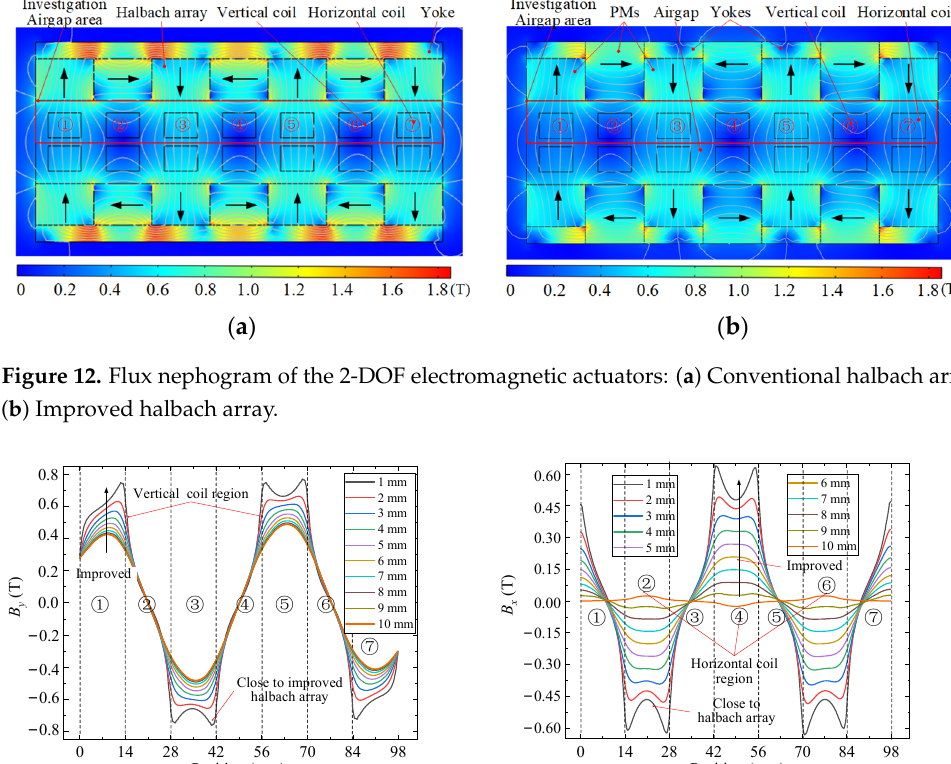
Figure 11. Comparison of design concepts of two schemes